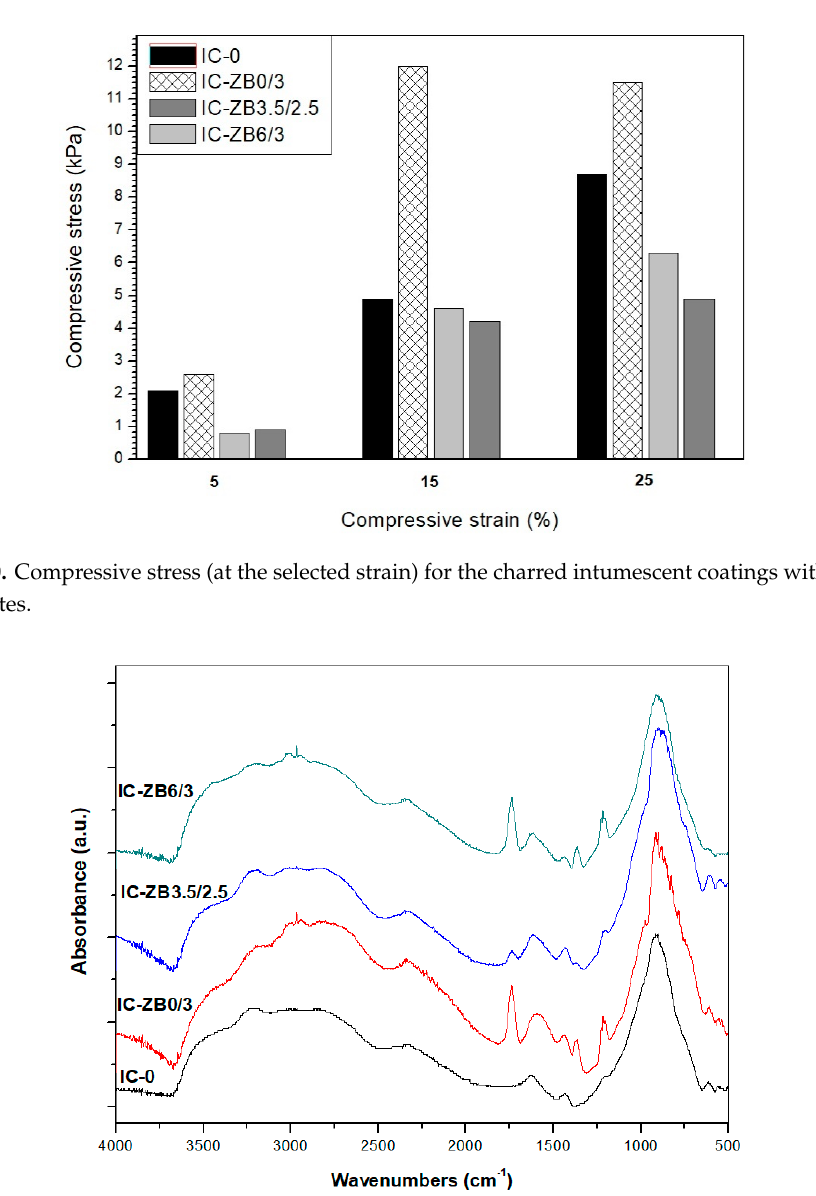
Figure 11. FTIR spectra for the charred intumescent coatings with various zinc borates.